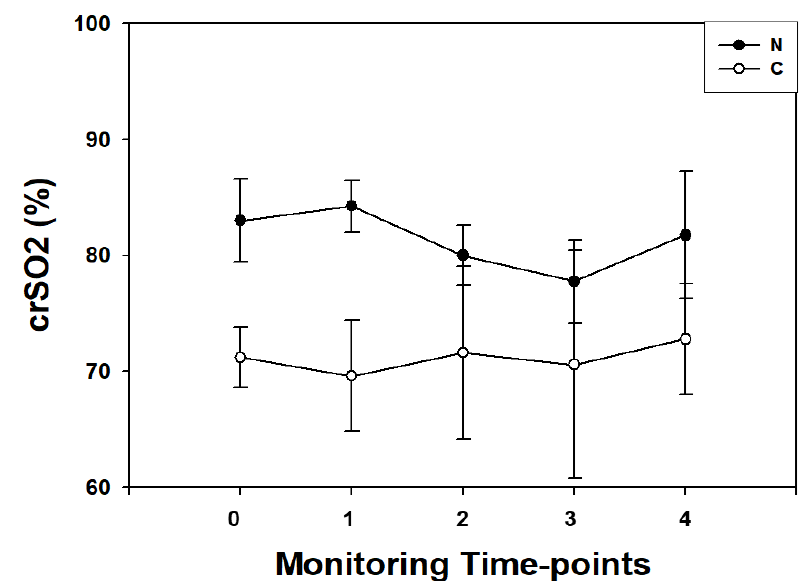
time-points while no differences ( p > 0.05, for all) were observed at T2-T4 time-points.